Question: Condense the content of this figure into a single sentence.
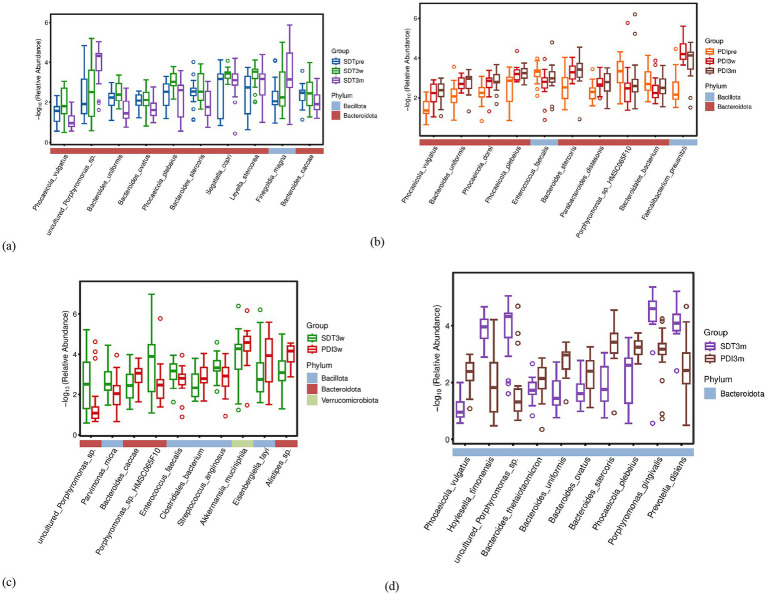
Answer: Characteristics of microbial dynamics and differential species abundance between the SDT group and PDI group. Four box plots display log 10 -transformed relative abundances. Boxes represent the interquartile range (IQR), horizontal lines indicate medians, whiskers extend to 1.5× IQR, and points beyond are outliers. The y -axis shows log 10 -transformed relative abundance; colored bars below the x -axis indicate phylum-level classification. Color coding: blue (SDTpre), green (SDT3w), purple (SDT3m), orange (PDIpre), red (PDI3w), and brown (PDI3m), consistent with other figures. (a,b) Intra-group longitudinal comparison: the top 10 differentially abundant species ( p < 0.05, Kruskal–Wallis for three time points or Wilcoxon signed-rank test for two time points) are shown in descending order of mean abundance. (a) SDT group. (b) PDI group. (c,d) Between-group comparison: the top 10 differentially abundant species ( p < 0.05, Wilcoxon rank-sum test) are shown in descending order of mean abundance. (c) SDT3w versus PDI3w. (d) SDT3m versus PDI3m.